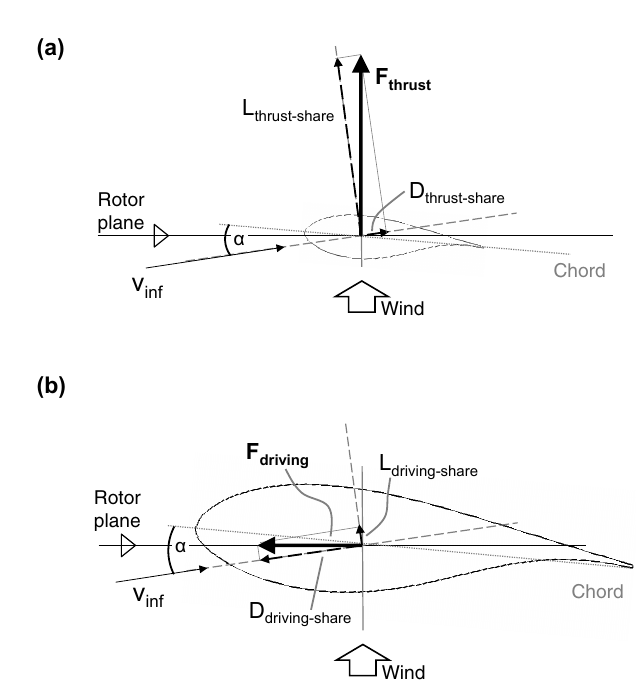
Figure 19. Transformation of driving force and thrust to local aero- dynamic coordinate system (driving force, a ; thrust, b ).